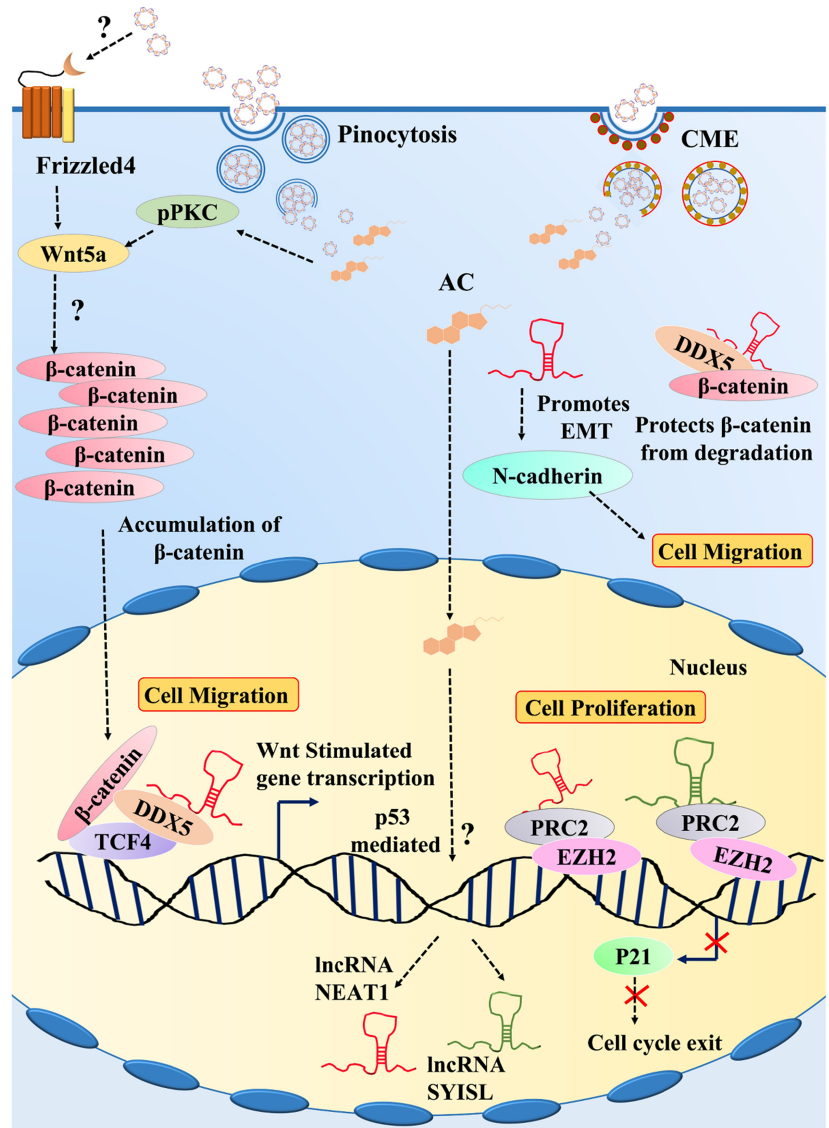
Figure 8. Demonstration of the signaling pathway triggered by IC in C2C12 myoblasts.